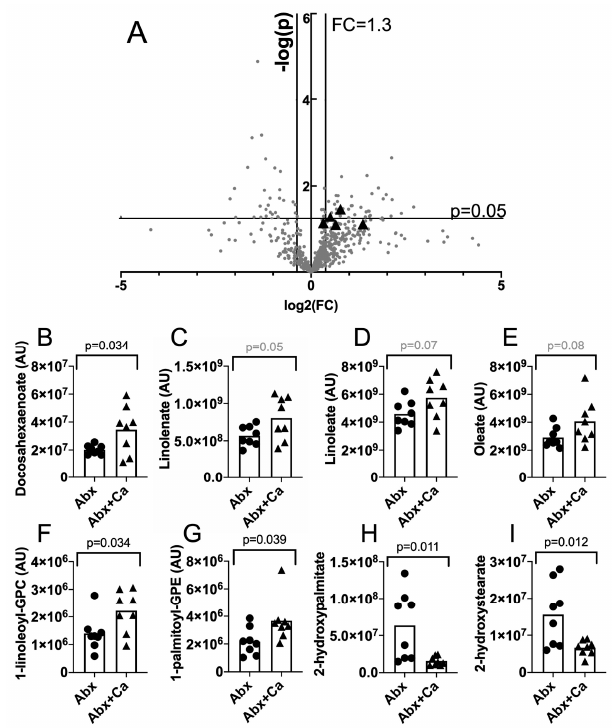
Figure 1. Untargeted metabolomic analysis of the cecum contents reveals higher levels of compounds related to linolenic acid metabolism in C. albicans -colonized mice. Mice were treated with antibiotics as described in Materials and Methods (cefoperazone, 10 days, rest 20 days, clindamycin ip). On the day following clindamycin treatment, the mice were sacrificed and the contents of the cecum were collected and frozen rapidly in dry ice / ethanol. These samples were analyzed by Metabolon using LC–MS / MS. Results were analyzed using Metaboanalyst. ( A ) Of the 595 compounds identified by Metaboanalyst, 590 are shown in a volcano plot (log2(FC) versus -log10( p )). The black triangles show the compounds in the enriched, linoleic and linolenic acid metabolism pathway. ( B – I ) Compounds showing altered levels or a trend toward altered levels in C. albicans -colonized mice. Each symbol shows the results from an individual animal. Bar shows the mean. Compounds (B–D) are in the linoleic and linolenic acid metabolism pathway. Circles, antibiotic treated, uncolonized; triangles, antibiotic treated, C. albicans colonized.